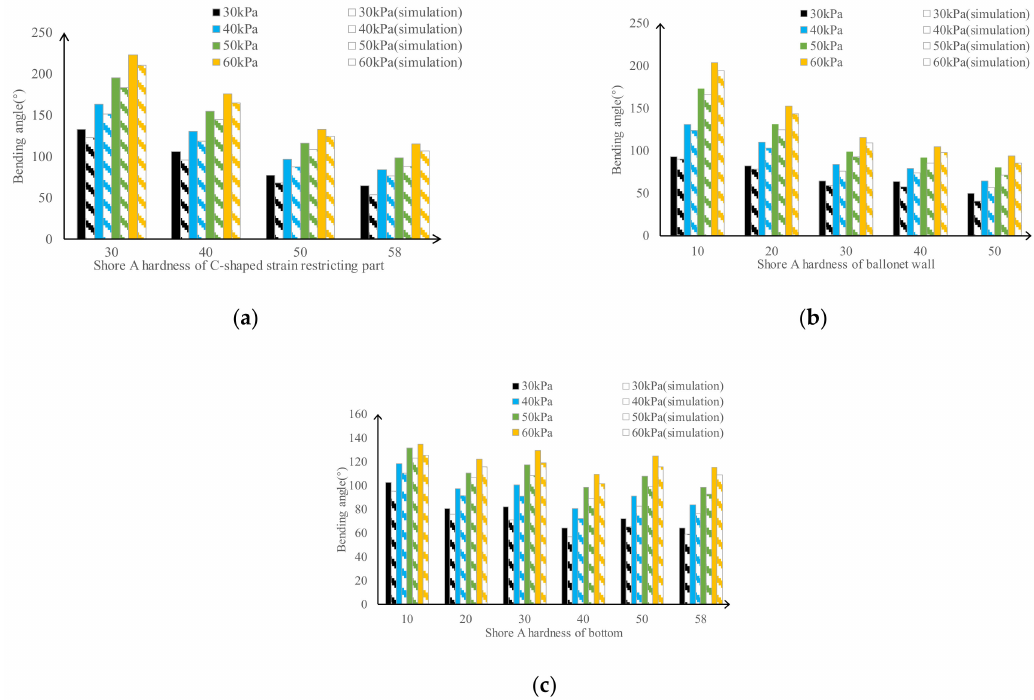
Figure 9. Experimental data and simulation data of bending angle: ( a ) The hardness of C-shaped strain-restricting part as variable. ( b ) The hardness of ballonet wall as variable. ( c ) The hardness of bottom as